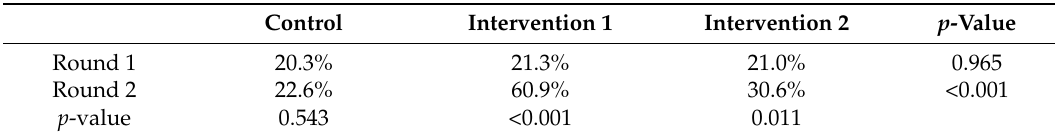
Table 7. DDI-related performance by intervention arm and round: Advise patient to stop interacting